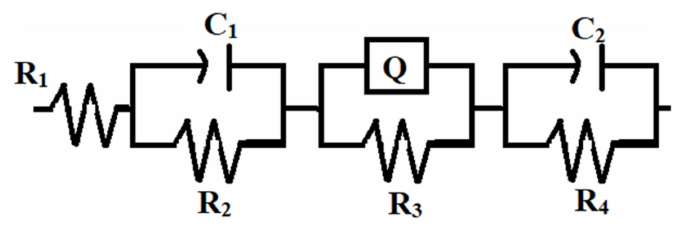
Figure 13. Equivalent circuit for the Zn and Zn–WO 3 composite